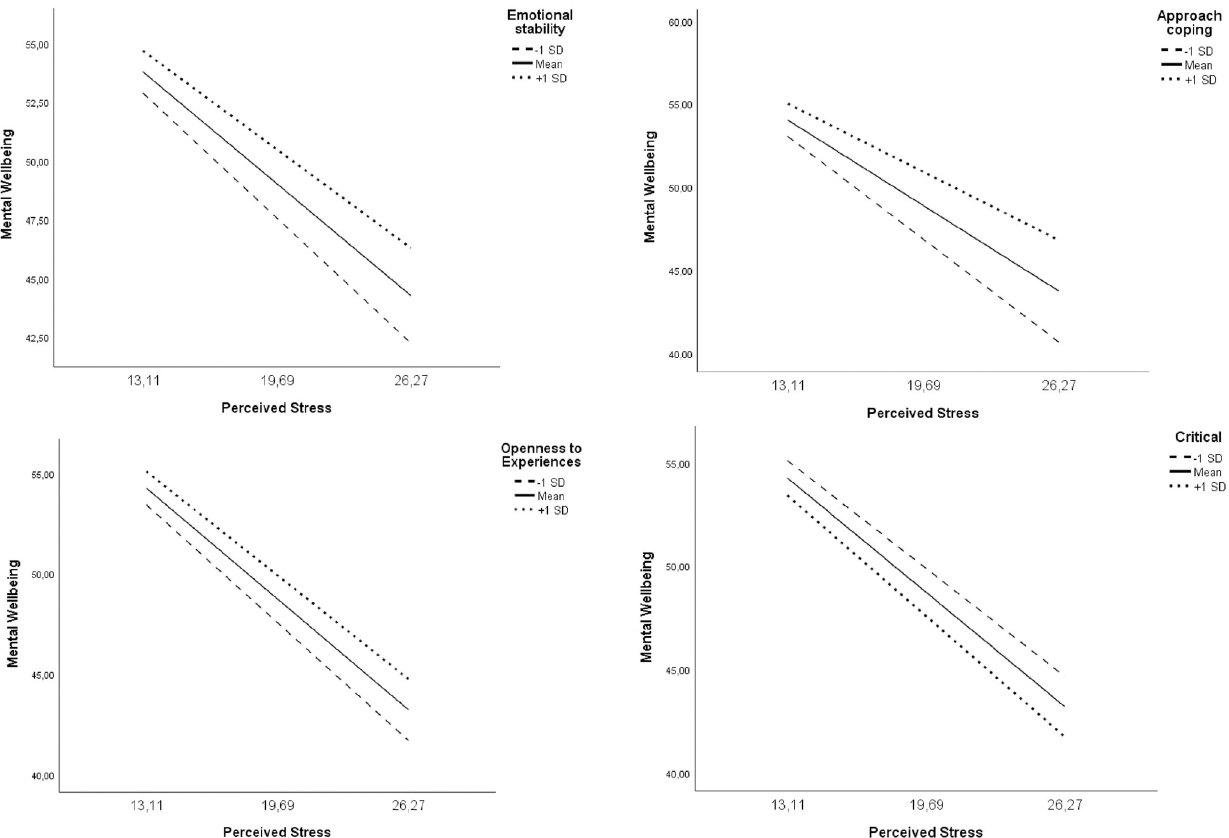
Fig 3. Simple slopes of perceived stress interacting with mental wellbeing for 1 SD below the mean, the mean, and 1 SD above the mean of emotional stability, approach coping, openness to experiences and critical.